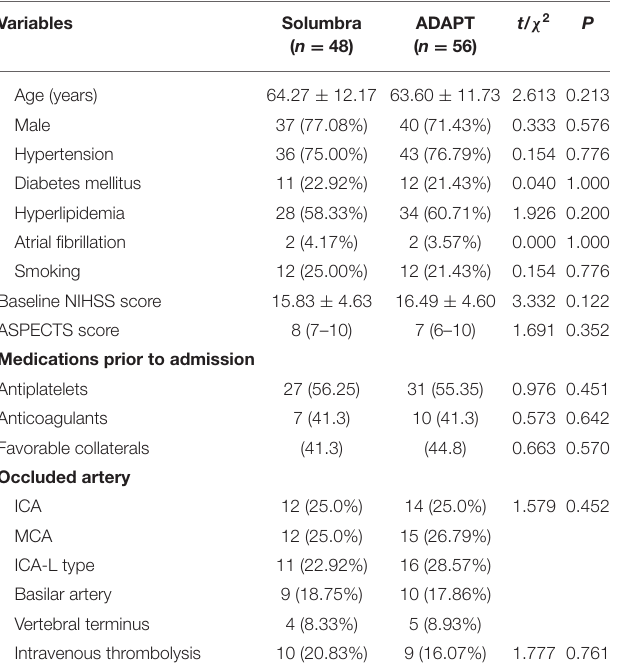
TABLE 3 | Clinical outcomes at 3-month